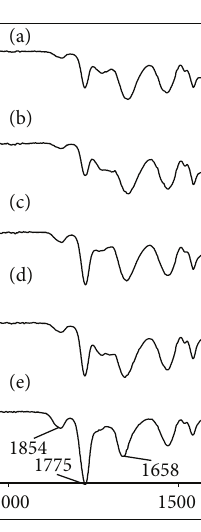
Figure 3: FTIR spectra of the poly(NTBA-co-MA)s preparing in different monomer feed. NTBA:MA; 70:30 (a), 60: 40 (b), 50:50 (c), 40 :60 (d), and 30 :70